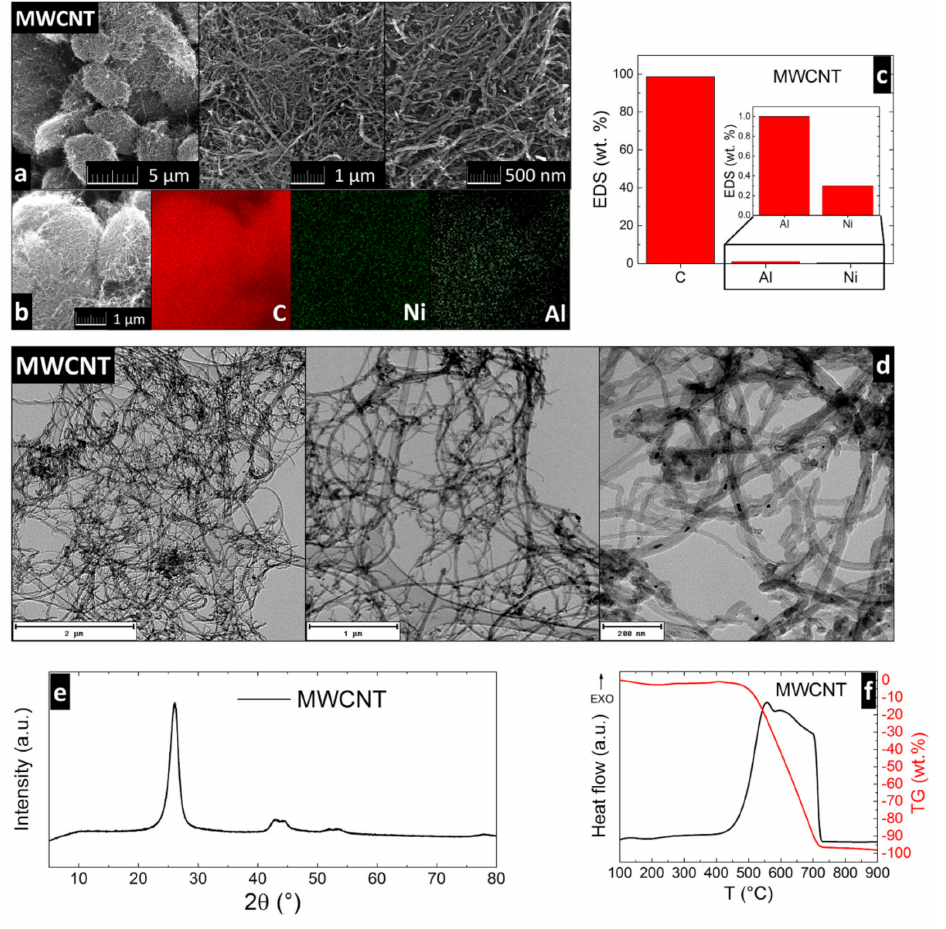
Figure 1. Analysis of multi-walled carbon nanotubes (MWCNTs): ( a ) SEM micrographs; ( b ) elemental maps of MWCNTs obtained by EDS; ( c ) quantity of the elements from EDS; ( d ) TEM micrographs; ( e ) diffraction pattern of MWCNTs; and ( f ) thermal behavior obtained by simultaneous thermal analysis